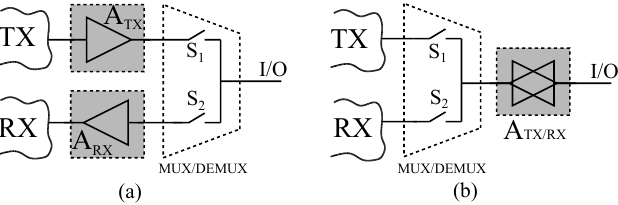
Figure 1. ( a ) typical approach to implement a transmitting and receiving system based on two different amplifiers; ( b ) proposed approach based on bidirectional